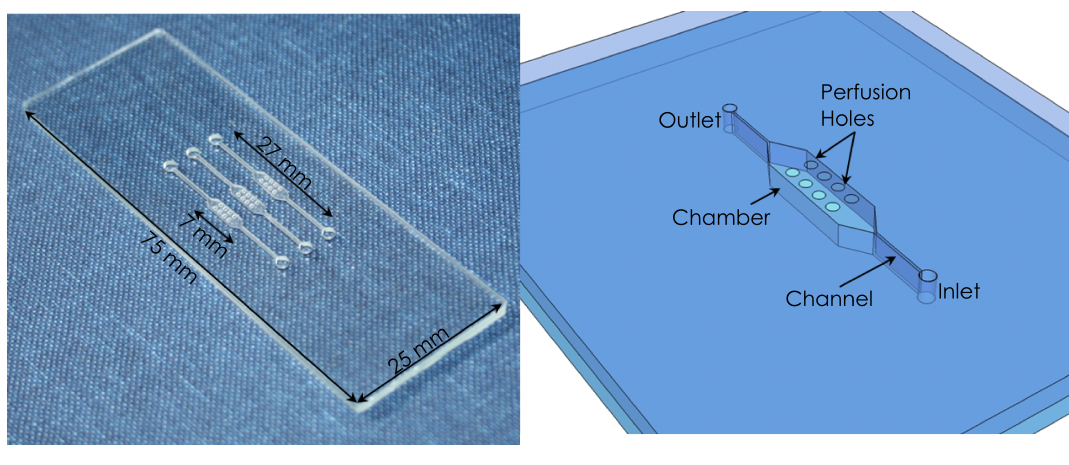
Figure 1. A semi-closed device for fast evaporation of the fixative-device image on the left and outline on the